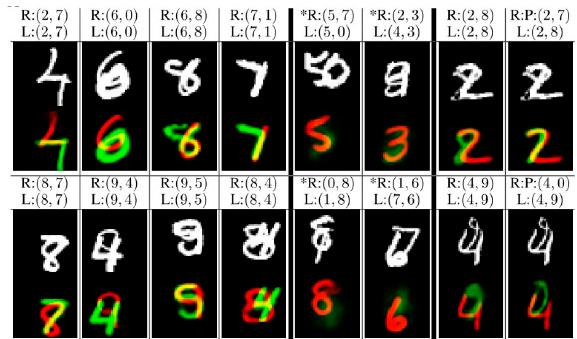
Figure 1. An example the capsule networks ability to carry out segmentation of highly overlapping digits in the Modified National Institute of Standards and Technology (MNIST) dataset [23].